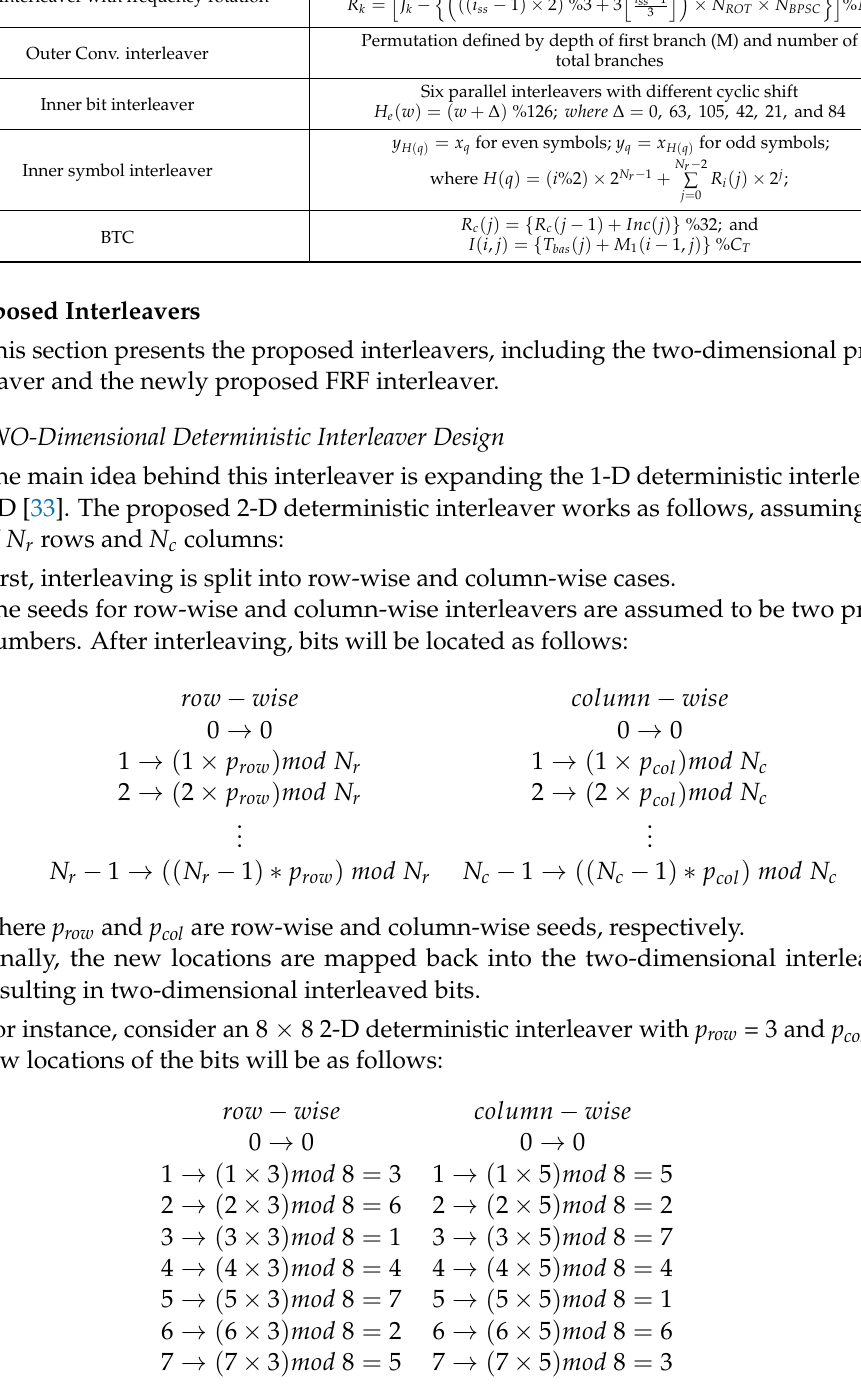
Ch. Interleaver with frequency